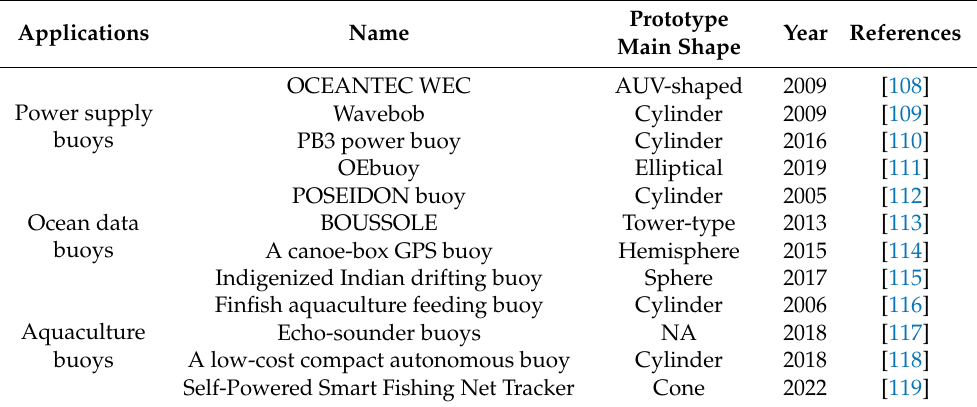
Table 3. Typical applications of marine